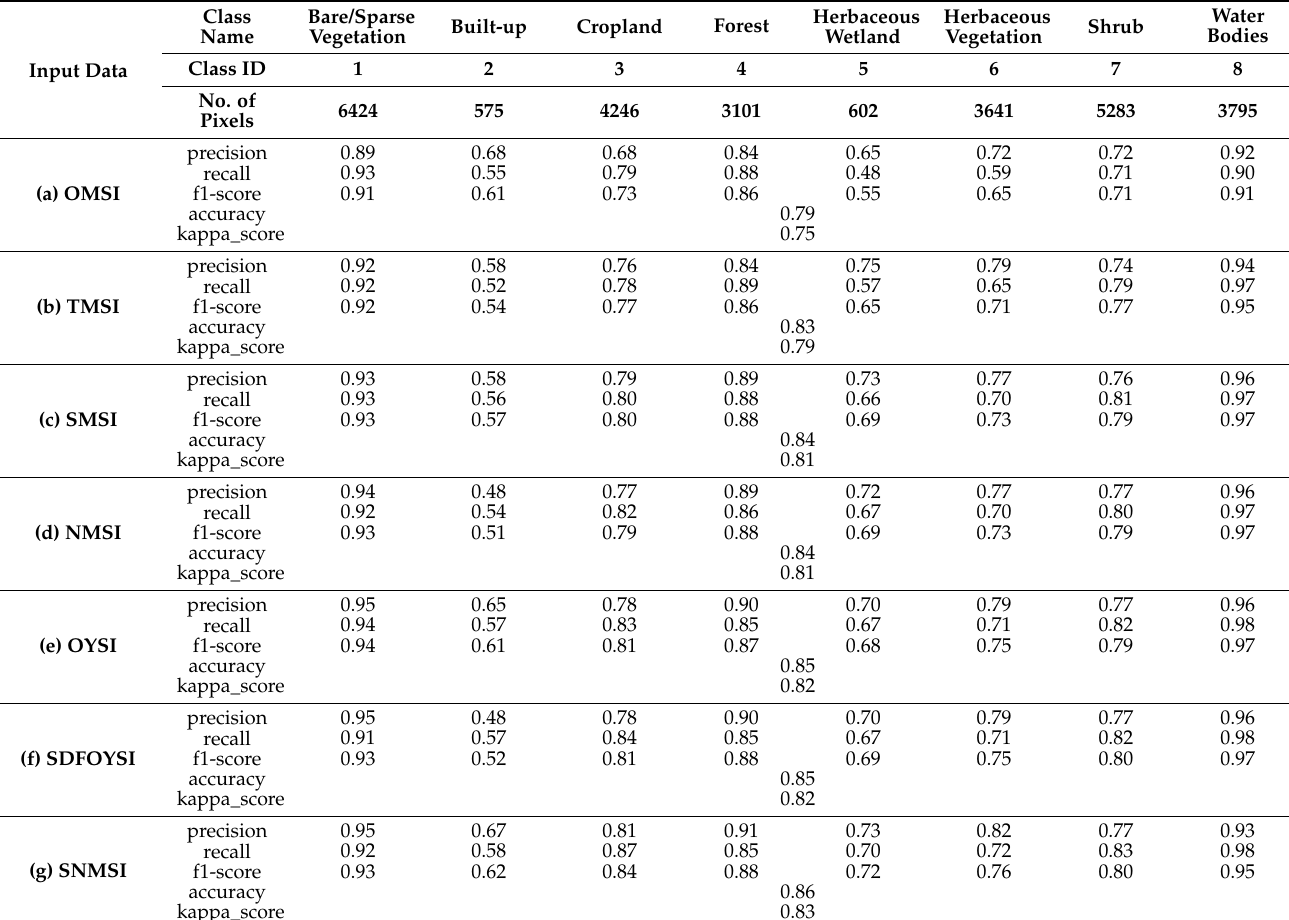
Table 4. Classification reports of seven different amounts of time series data